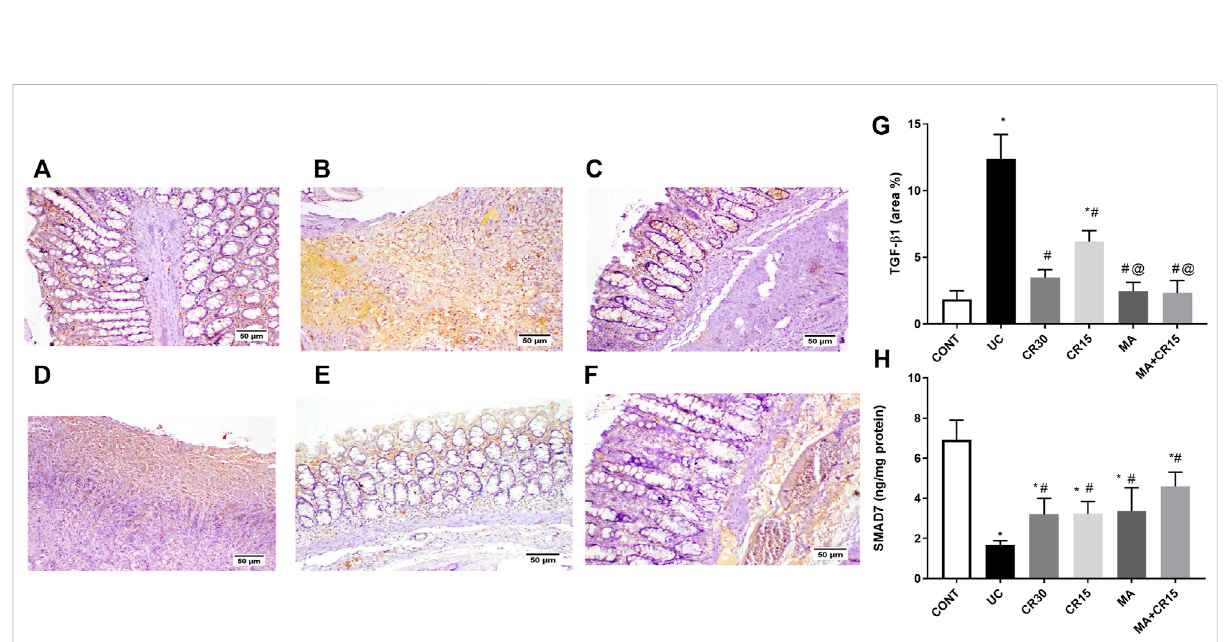
FIGURE 8 Effect of mirabegron and/or carvedilol on colon TGF- β 1 immunoreactivity and SMAD7 content in rats with IAA-induced ulcerative colitis. Section of (A) CONT group, shows a normal expression of TGF- β 1, while that of (B) UC group shows increased expression of TGF- β in the ulcerative mucosa.Treatmentwith (C) CR30revealsmoderateexpressionofTGF- β 1,whereastreatmentwith (D) CR15onlylessenedtheexpressionofTGF- β 1. Sections of (E) MA and (F) MA+CR15 treated groups show few expressions of TGF- β 1 in the mucosa. (G) presents the % area of TGF- β 1 staining (5 fi elds in each section) and (H) represents the effect on SMAD-7. Data are presented as mean ± SD (n = 3 – 6). Statistical analysis was carried out using one-way ANOVA followed by Tukey ’ s posthoc test; p < 0.05, as compared to the (*) CONT, (#) UC, and (@) CR15 groups. CONT, control; CR, carvedilol; IAA, iodoacetamide; MA, mirabegron; TGF- β 1, transforming growth factor beta; UC, ulcerative